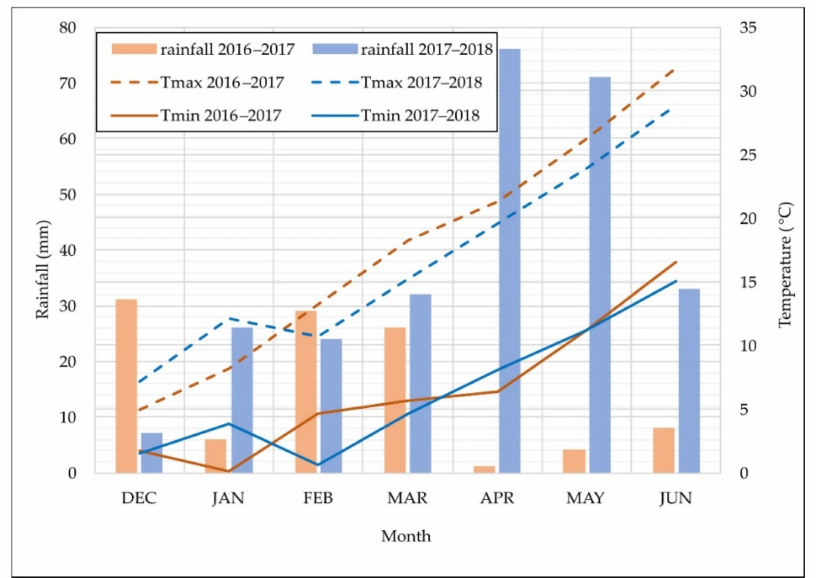
Figure 3. Monthly rainfall (mm), and minimum (Tmin) and maximum (Tmax) temperatures during the growth cycle of each growing